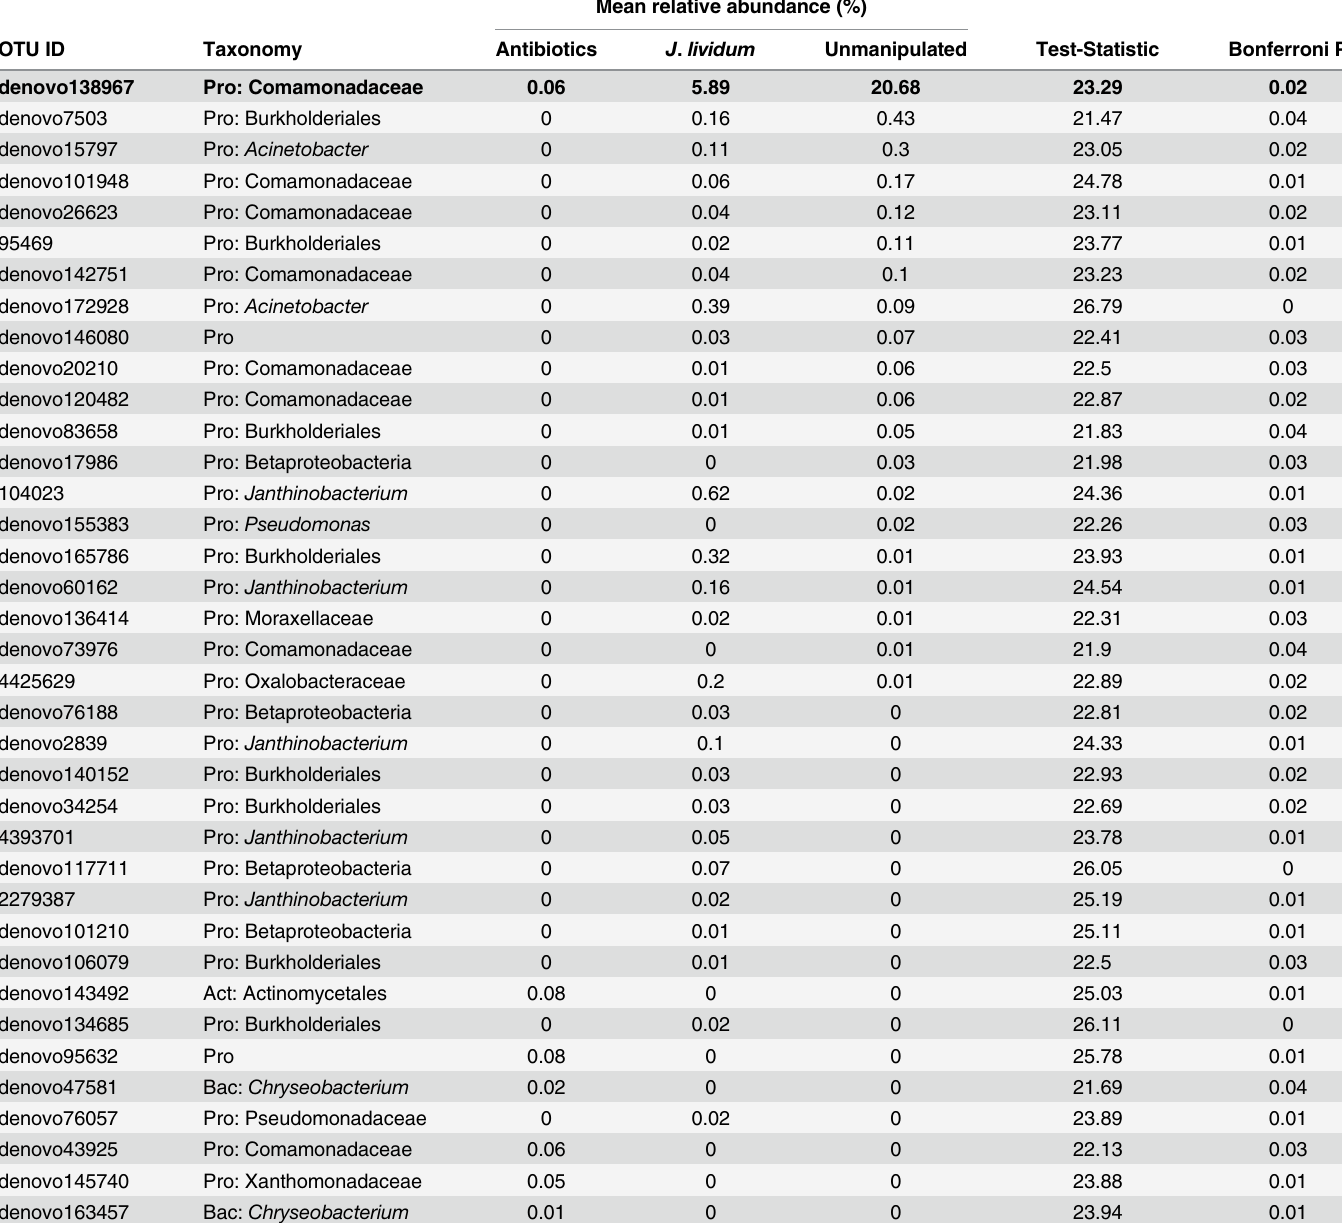
Table 2. List of 37 OTUs that differed significantly in relative abundance among microbiota manipulation treatments (antibiotics, augmented with J . lividum , and unmanipulated) 7 days after exposure to Bd, based on a Kruskal-Wallis test with Bonferroni corrected P values. Taxonomy includes the phylum and the lowest classification that could be defined for each OTU. Phyla are abbreviated as follows: Act = Actinobacteria, Bac = Bacteroidetes, Pro = Proteobacteria. OTUs are ranked in order of relative abundance in the unmanipulated treatment. The Comamonadaceae OTU that was positively corre- lated with frog growth among Bd-exposed frogs is bolded. Representative 16S rRNA gene sequences for these 37 OTUs can be found in S1